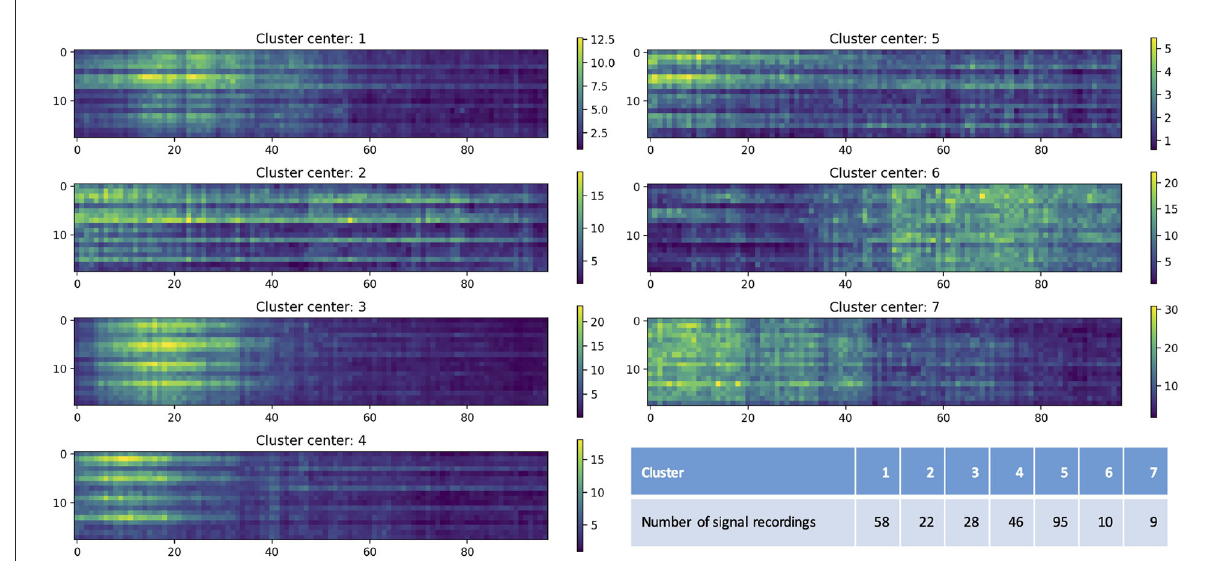
FIGURE5 Cluster centers obtained by the K-means clustering algorithm. The x-axis indicates the time after the end of the seizure (in seconds; only shows the first 100 seconds) and y-axis represents the channels (1–18 represent Fp1-F7, F7-T7, T7-P7, P7-O1, Fp2-F8, F8-T8, T8-P8, P8-O2, Fp1-F3, F3-C3, C3-P3, P3-O1, Fp2-F4, F4-C4, C4-P4, P4-O2, Fz-Cz, and Cz-Pz). Colors indicate the value of the artifact features. The table lists the number of EEG recordings in each